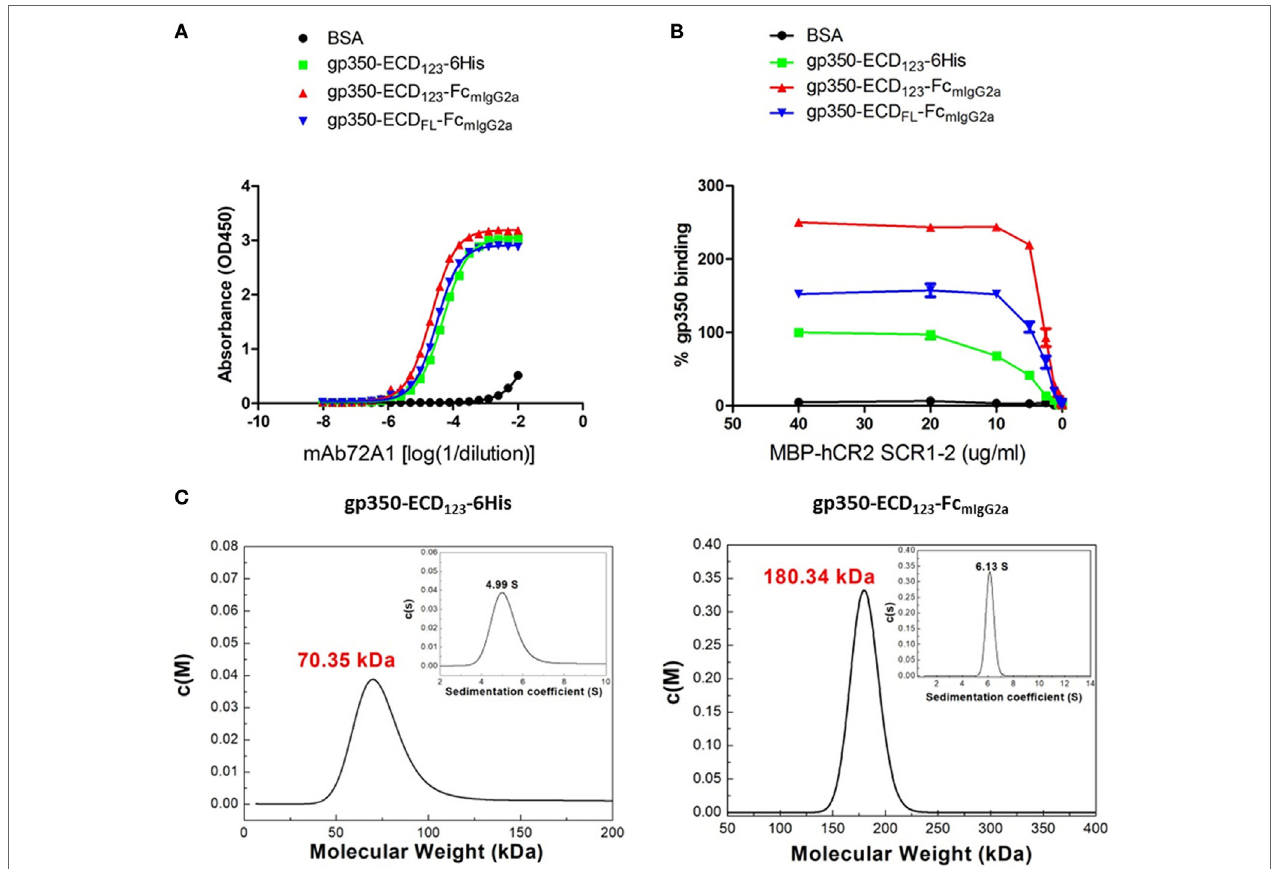
FigUre 2 | Molecular weight determination and binding kinetics analysis for recombinant gp350. (a) Binding of the indicated forms of recombinant gp350 to conformation-dependent neutralizing monoclonal antibody mAb72A1 by enzyme-linked immunosorbent assay (ELISA). BSA was included as negative control. (B) Binding of the indicated forms of recombinant gp350 to purified receptor MBP-hCR2 SCR1-2 by ELISA. Binding was normalized to maximum binding to monomeric gp350- ECD 123 -6His. BSA was included as negative control. The Fc fusion proteins bound CR2 more effectively than the monomeric gp350. (c) Analytical ultracentrifugation determination of molecular weight of the indicated forms of recombinant gp350 after purification. Sedimentation coefficients and molecular weights are indicated.